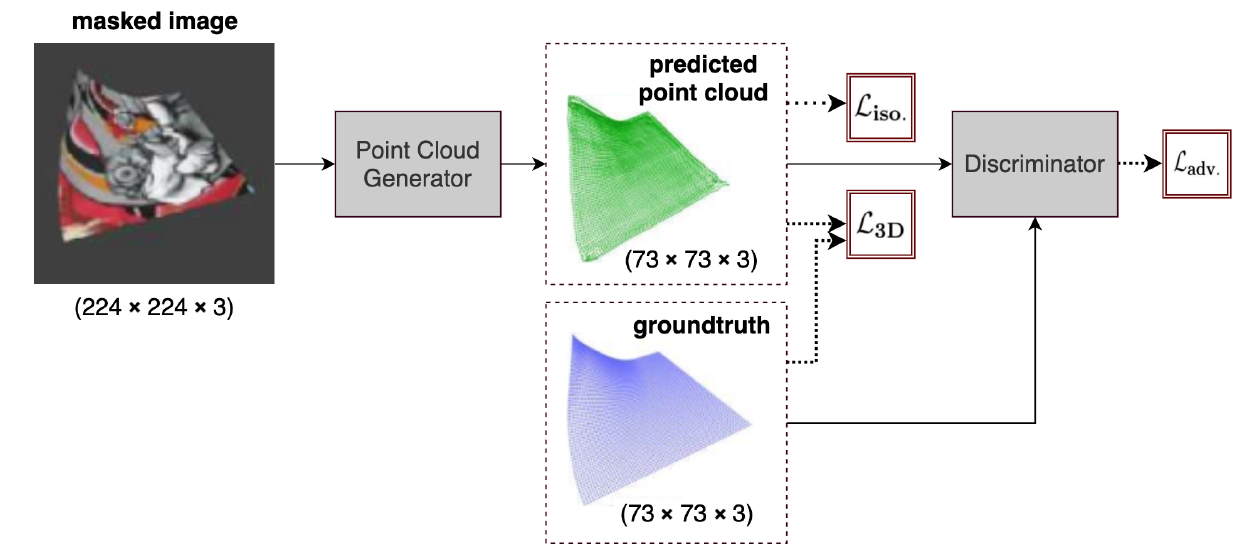
Figure 6. Overview of IsMo-GAN [6]. The generator network accepts a masked RGB image, seg- mented by the object detection network (OD-Net), and returns a 3D point cloud. The output and ground-truth are fed to the discriminator which serves as a surface